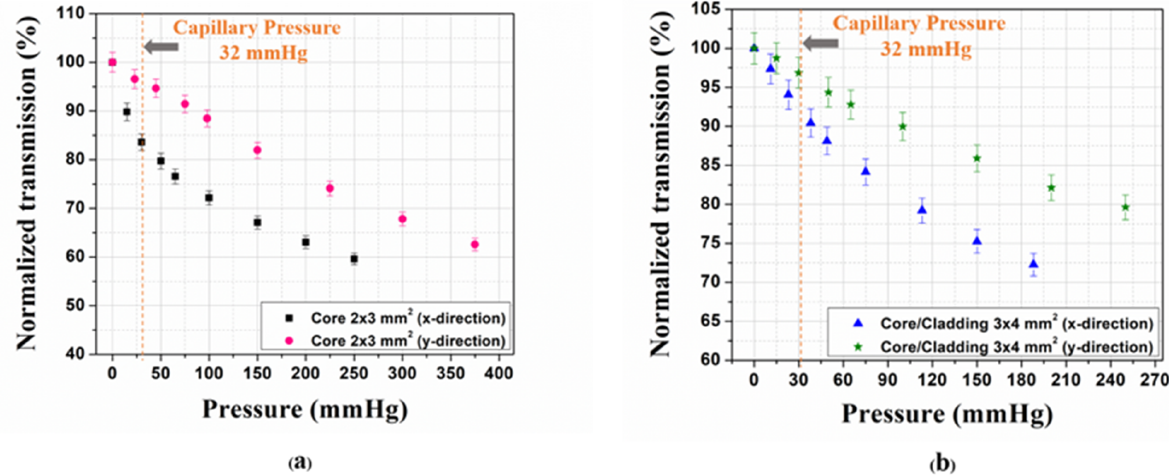
Figure 6. Waveguides (0.1% BPh/wt.): normalized transmission as a function of pressure applied, ( a ): 2 × 3 mm 2 , core/air-clad; ( b ): 3 × 4 mm 2 , core/cladding.